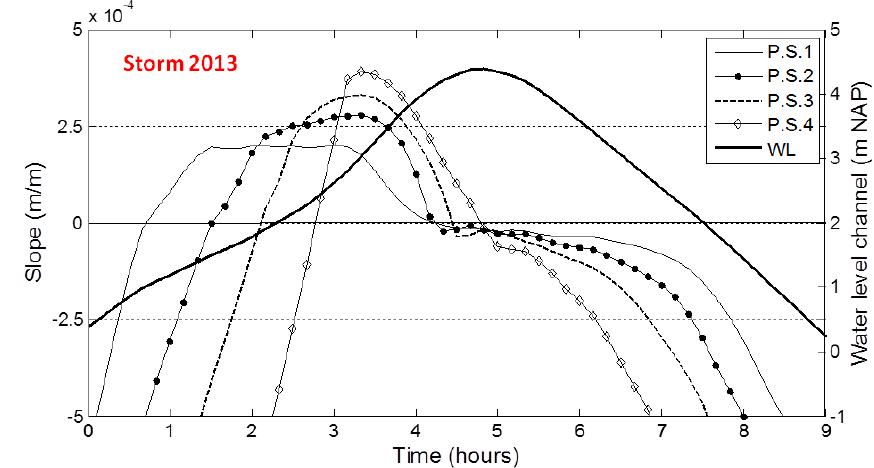
Figure 7. Water surface slopes for scenarios P.S.1, P.S.2, P.S.3 and P.S.4 for the storm tide of 1994 between middle of the main estuarine channel and the wetland edge (distance was about 1000m). Positive slopes occur when the water floods from the main channel onto the wetland and negative slopes when the water drains again from the wetland towards the main channel. As a reference, the water level fluctuation in the main estuarine channel (thick black line) is given with values on the right y axis.